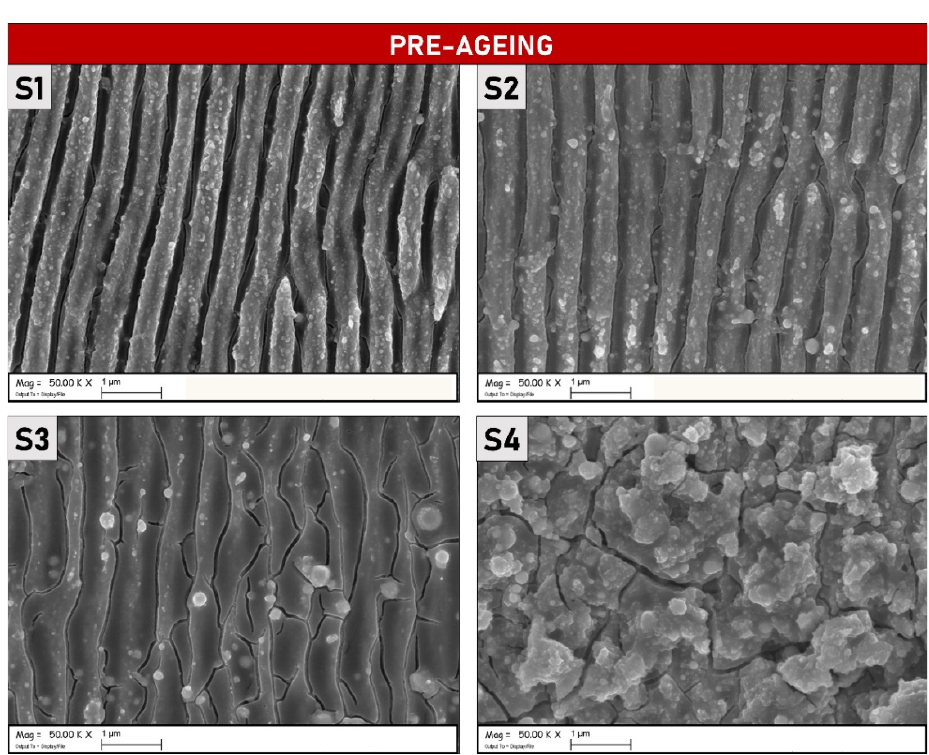
Figure 1. SEM micrographs (magnification 50 k×) of the four different Molybdenum samples after laser irradiation. The experimental parameters used for the ( S1 ), ( S2 ), ( S3 ) and ( S4 ) LIPSS fabrications are reported in Table 1.